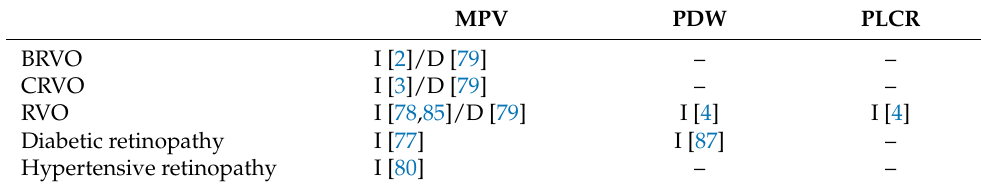
Table 2. Platelet-derived parameters in selected ophthalmology